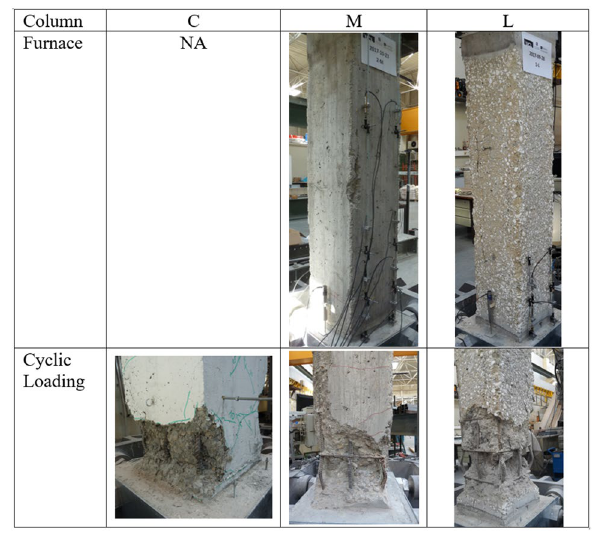
Figure 6. The three tested specimens (i.e., C, M and L) after being exposed to elevated temperatures (where applicable) and after their failure to cyclic loading.